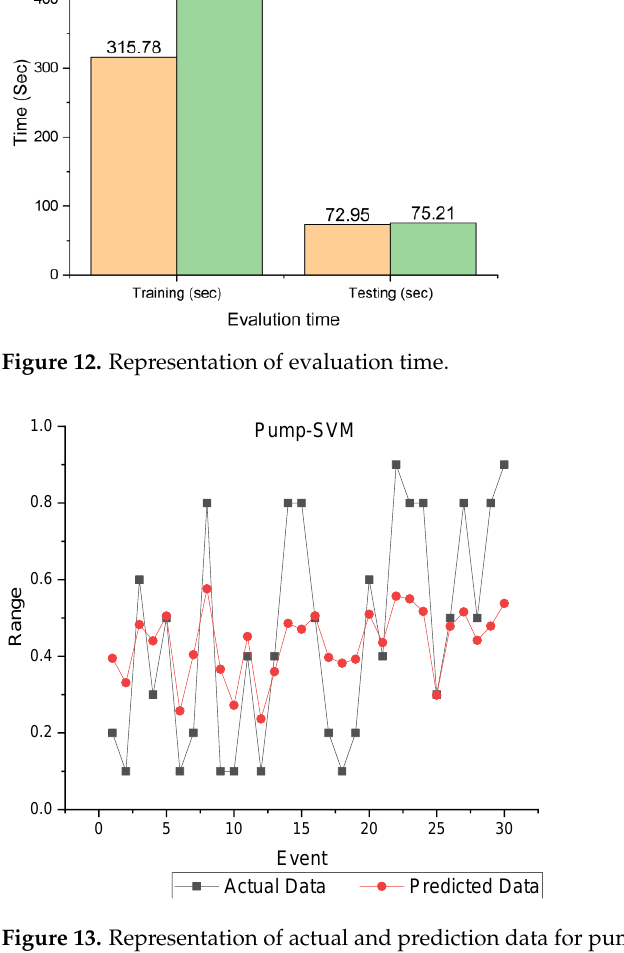
Figure 13. Representation of actual and prediction data for pump SVM.